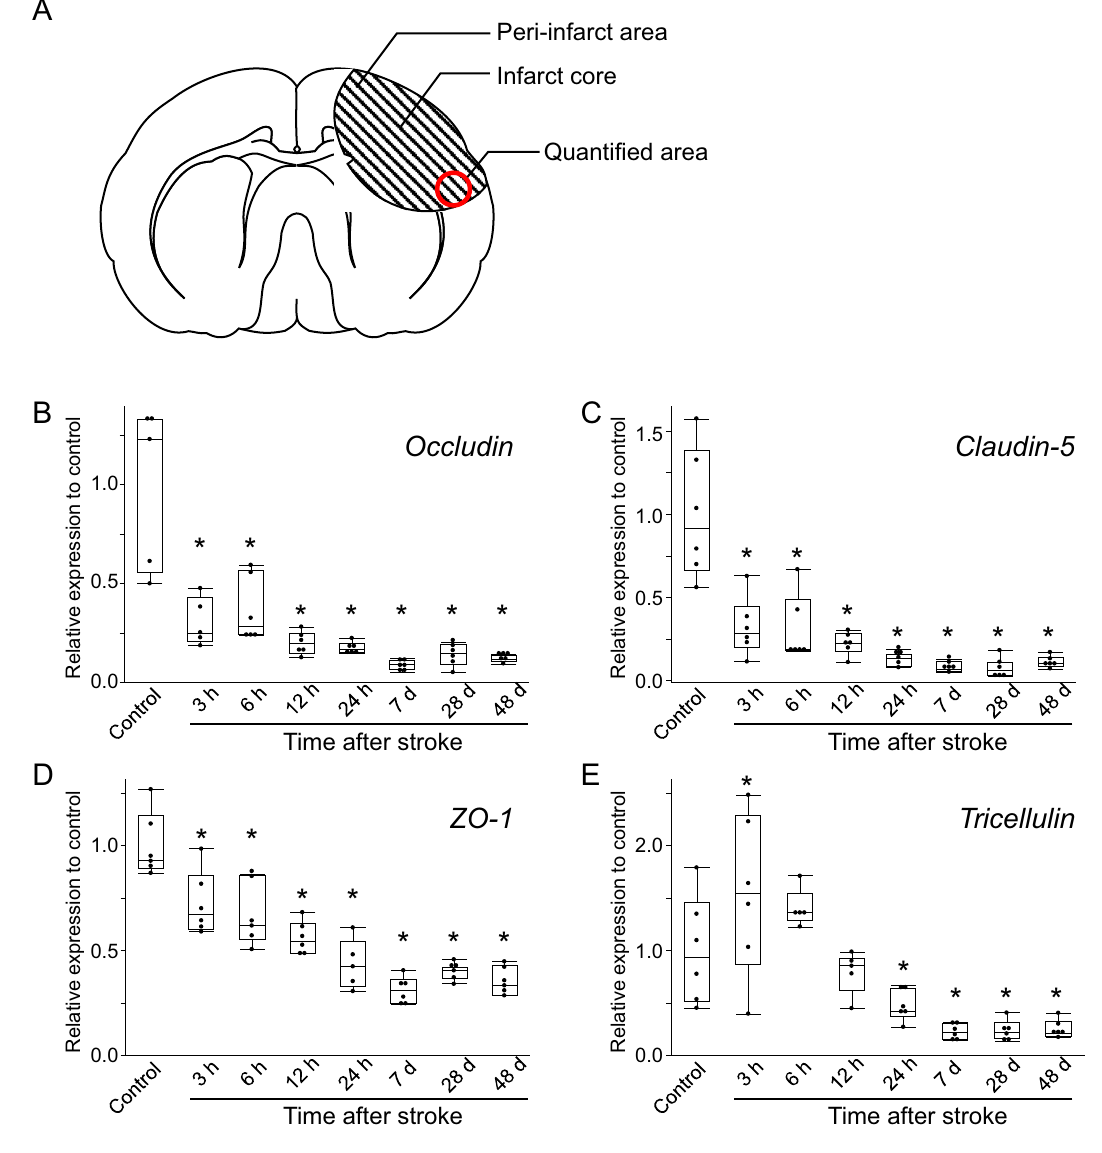
Figure 1. mRNA expression level of tight junction proteins of the blood–brain barrier after cerebral infarction. Quantification of mRNA expression was performed using samples collected from the peri-infarct area shown in ( A ). Box and whiskers with the maximum and minimum relative expression levels of occludin ( B) , claudin-5 ( C ), ZO-1 ( D ), and tricellulin ( E ) are shown. The expression levels of occludin, claudin-5, and ZO-1 are decreased after 3 h. The expression of tricellulin is decreased after 24 h. The mRNA expression is normalized to that of β-actin (ΔCt = Ct target–Ct actin). Dunnett’s test is performed. * P < 0.05 vs control. n = 5–6